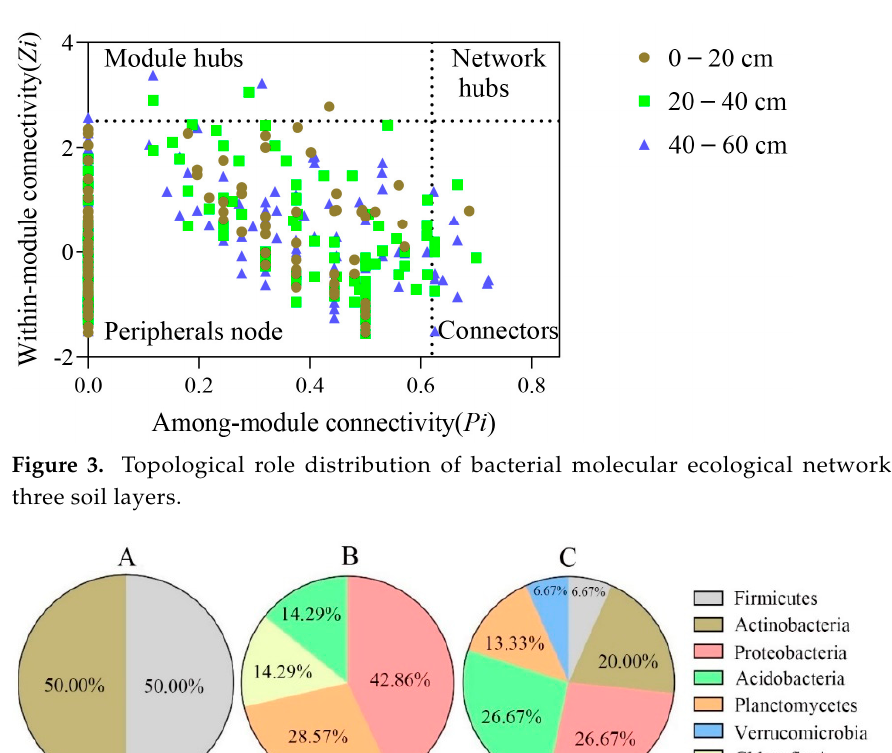
Figure 2. Venn diagram of node distribution of bacterial molecular ecological network in three soil layers.